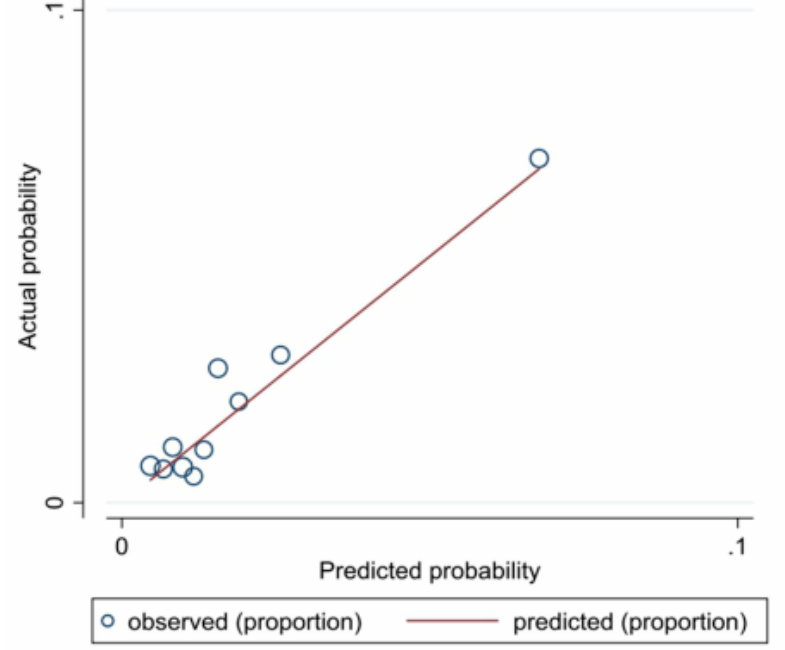
Figure 5. Calibration plot with distribution of the predicted probabilities for individuals with and without in-hospital bleeding in the validation data